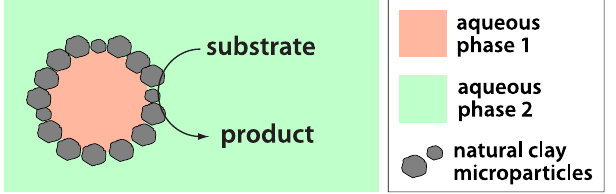
Figure 1. Natural clay particles catalyzing reactions in aqueous two-phase